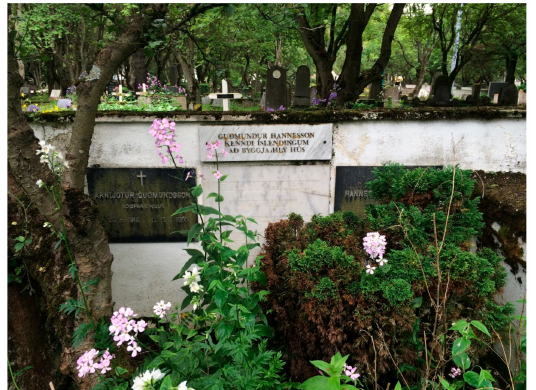
Figure 5. Guðmundur Hannesson’s grave and epitaph at H ó lavallagarður cemetery, Reykjav í k (Photo by the author,